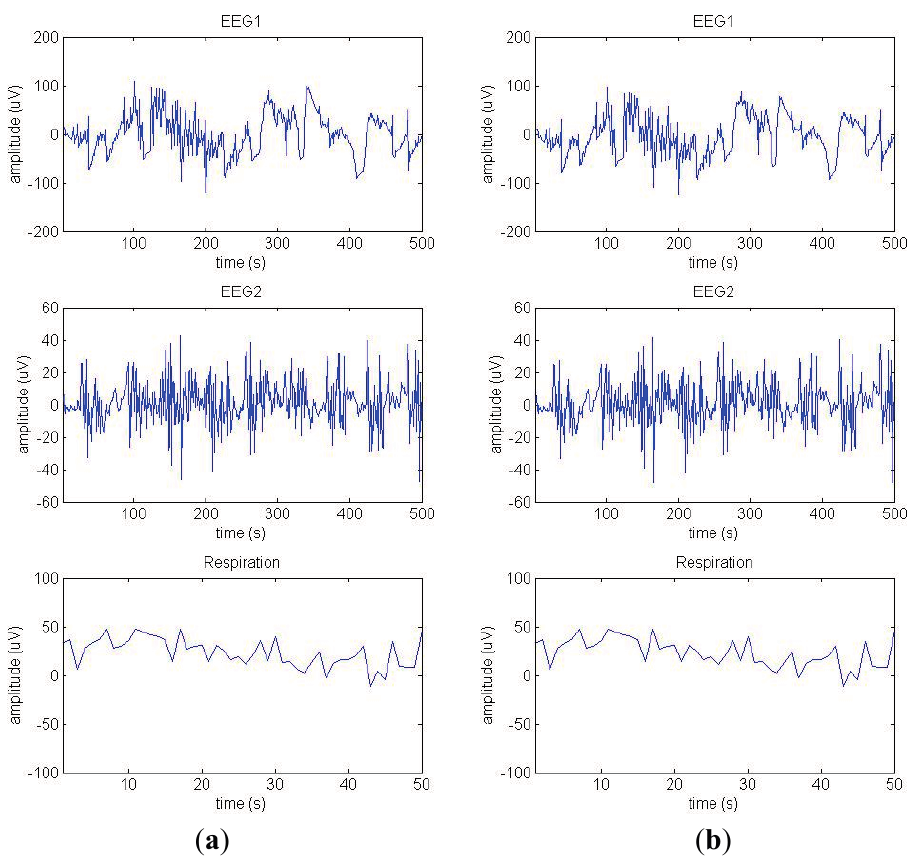
Figure 3. ( a ) Raw EEG1 (Fpz-Cz), EEG2 (Pz-Oz), and respiration signals; ( b )